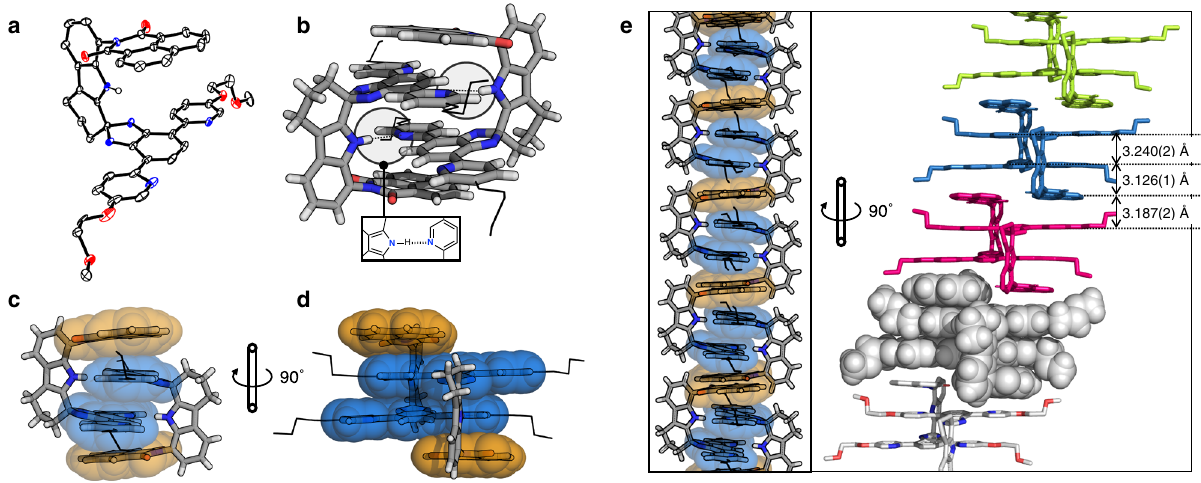
Fig. 4 Self-dimerization and hierarchical self-assembly. X-ray structures of C-NI as a ORTEP diagram with thermal ellipsoids at the 50% probability level. Hydrogen atoms have been omitted for clarity, except for the indole N – H group participating in the intermolecular N – H···N pyridyl hydrogen bond shown in ( b ). Capped-stick representations b – d are constructed from crystallographically determined atomic coordinates of [ C-NI ] 2 viewed from different perspectives. The ether chains are simpli fi ed as wireframes; van der Waals surfaces are overlaid on the aromatic groups constituting the quadruple π - stacks with color schemes shown in Fig. 1. e Capped-stick and space- fi lling models of an in fi nite vertical stack of {[ C-NI ] 2 } ∞ .; each [ C-NI ] 2 dimer is color- coded differently to denote the repeating unit and highlight inter-dimer shape complementarity. ORTEP Oak Ridge thermal ellipsoid